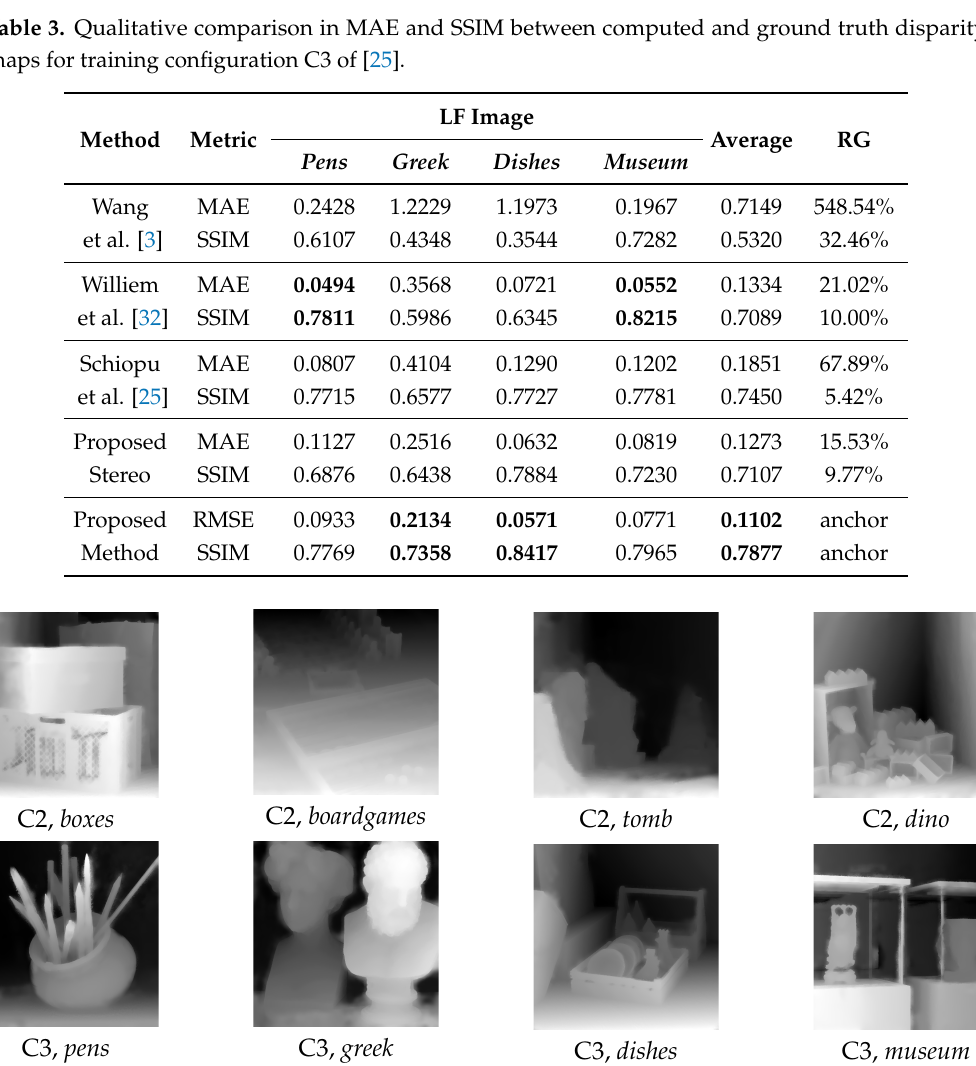
Figure 9. Disparity maps for the Proposed Method for configuration C2 and C3 of